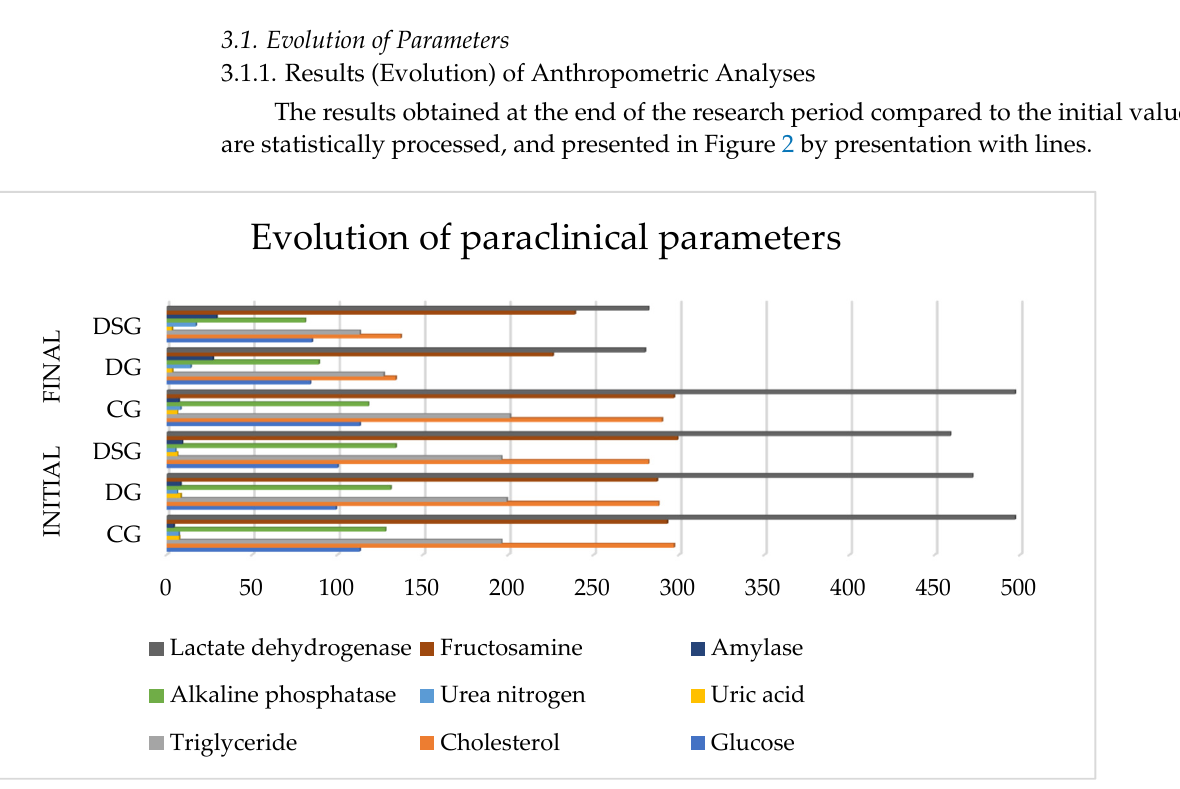
Figure 2. Evolution of paraclinical parameters in all three research groups. The graphical representation of the mean values of BMI, fat mass, visceral fat, and ECW/TBW, described in Table 3 looks like this: in CG, a statistically significant worsening of the parameters can be observed ( p < 0.05) which can be seen from the negative value of “ t ” in the case of BMI, fat mass and visceral fat.